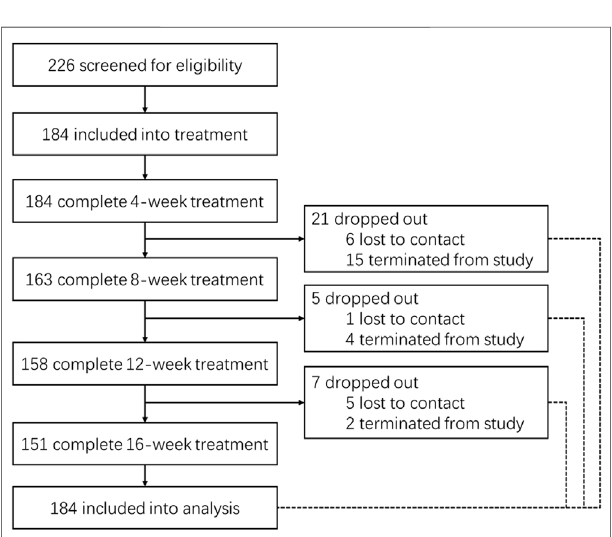
FIGURE 3 | The fl ow chart of participants 12 participants were lost to contact while 21 participants were terminated from this study. This participants who showed syncope during the treatment with heart rate less than 30 bpm were terminated from this study and referred for further treatment, if